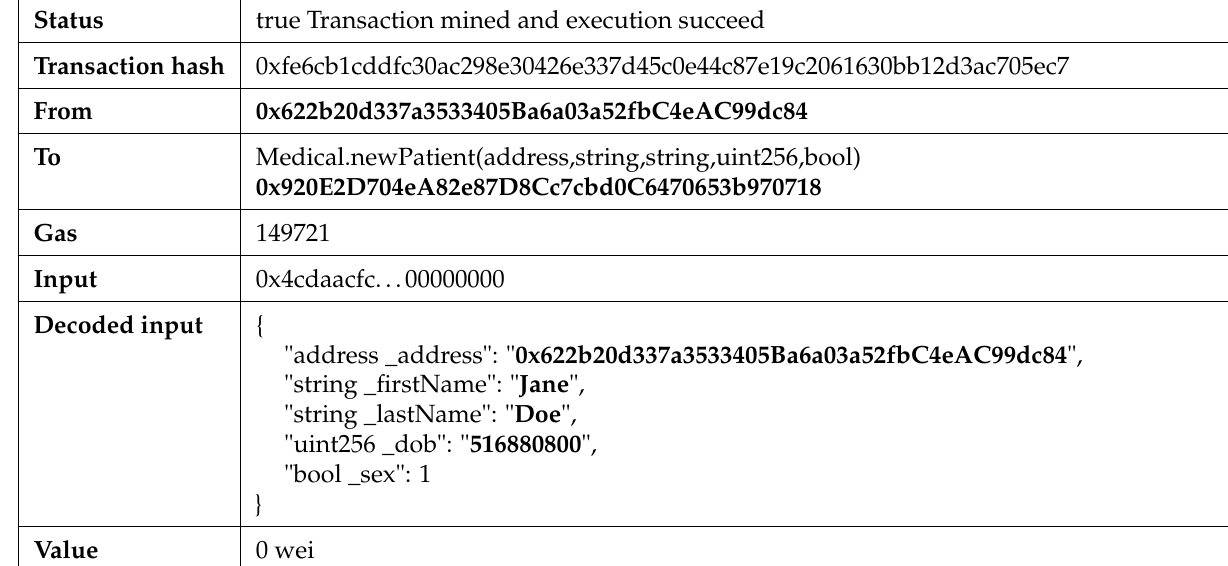
Figure 8. New patient transaction on the Ethereum blockchain.